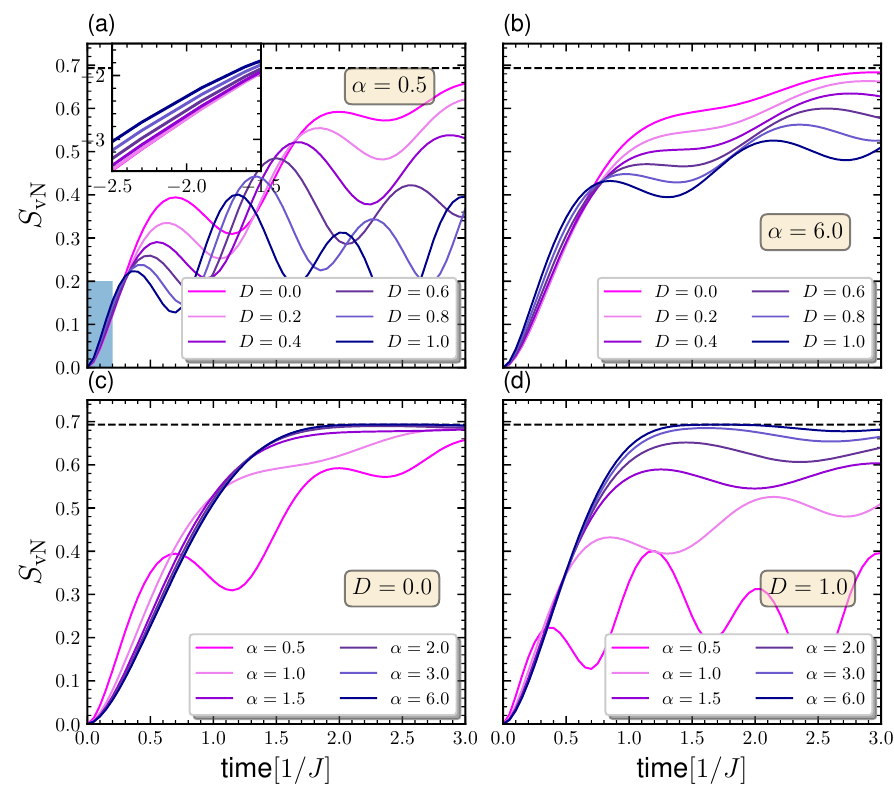
Figure 8: (colour online) Growth of half-chain entanglement entropy S parameters in the Hamiltonian of Eq.(1). The horizontal dashed line is saturate value ( t ) = log2. Insert plot illustrates shaded area in logarithmic scale. Data for chain S vN size L = 23 and ∆ =